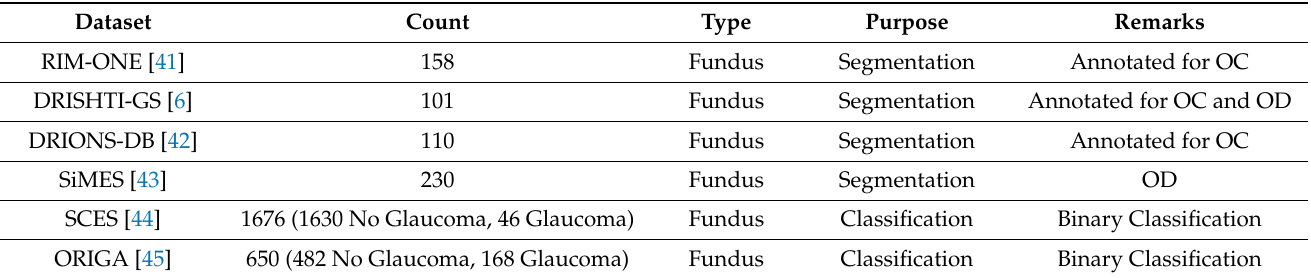
Figure 6. Confusion matrices for the best performing algorithms among all classifiers. Table 4. Datasets Details for the Glaucoma